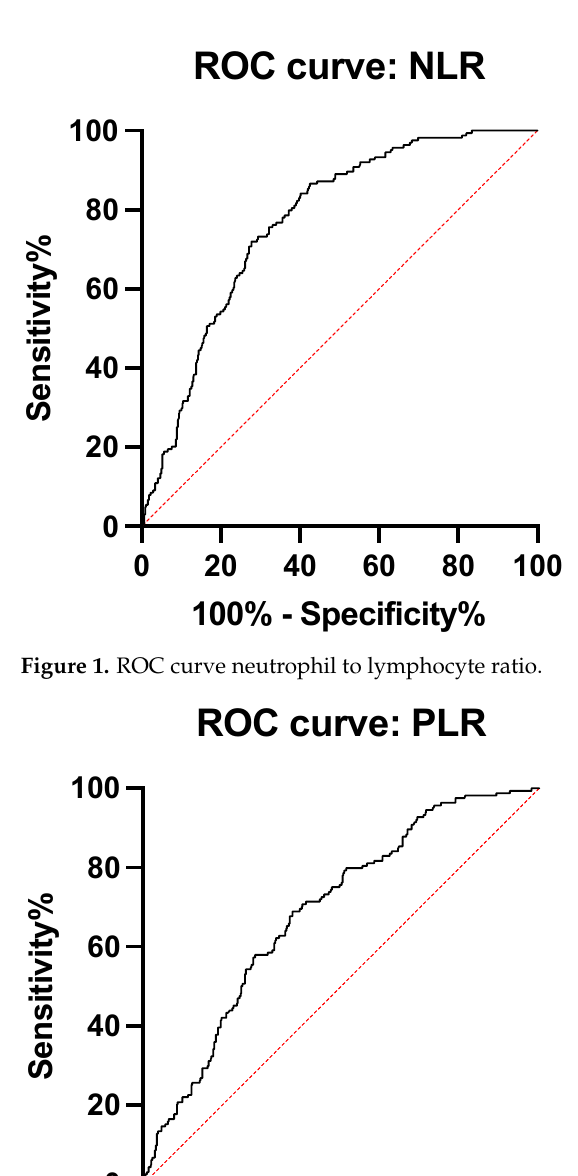
Figure 2. ROC curve platelets to lymphocyte ratio. Table 3. ROC curves results of the novel biomarkers and inflammatory standard tests. (CRP-AUC = 0.72, fibrinogen-AUC = 0.70, ESR-AUC = 0.66), NLR remains a good pre- dictor of appendicular